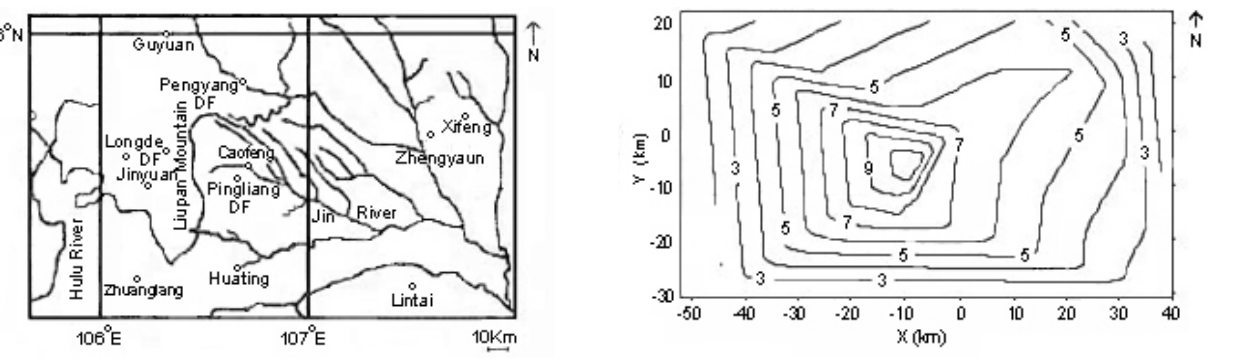
Fig. 1. The distribution of the main precipitation observation sta- tions in the eastern Gansu area.